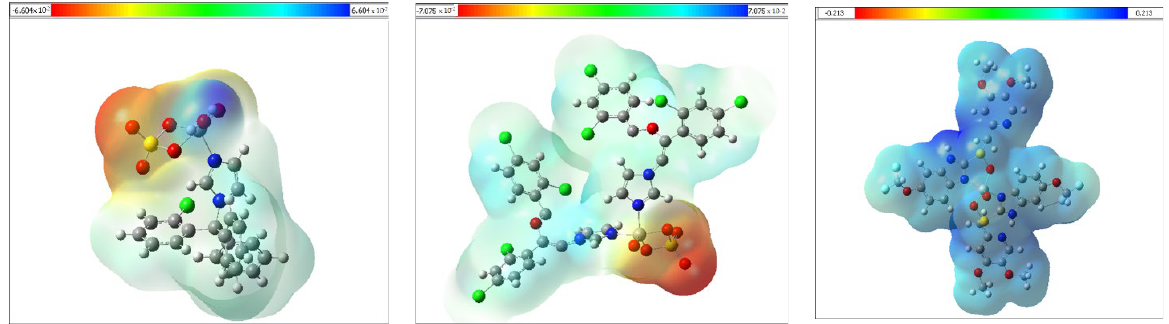
Figure 4. The molecular electrostatic potential surface of the metal complexes calculated by the DFT/B3LYP level.